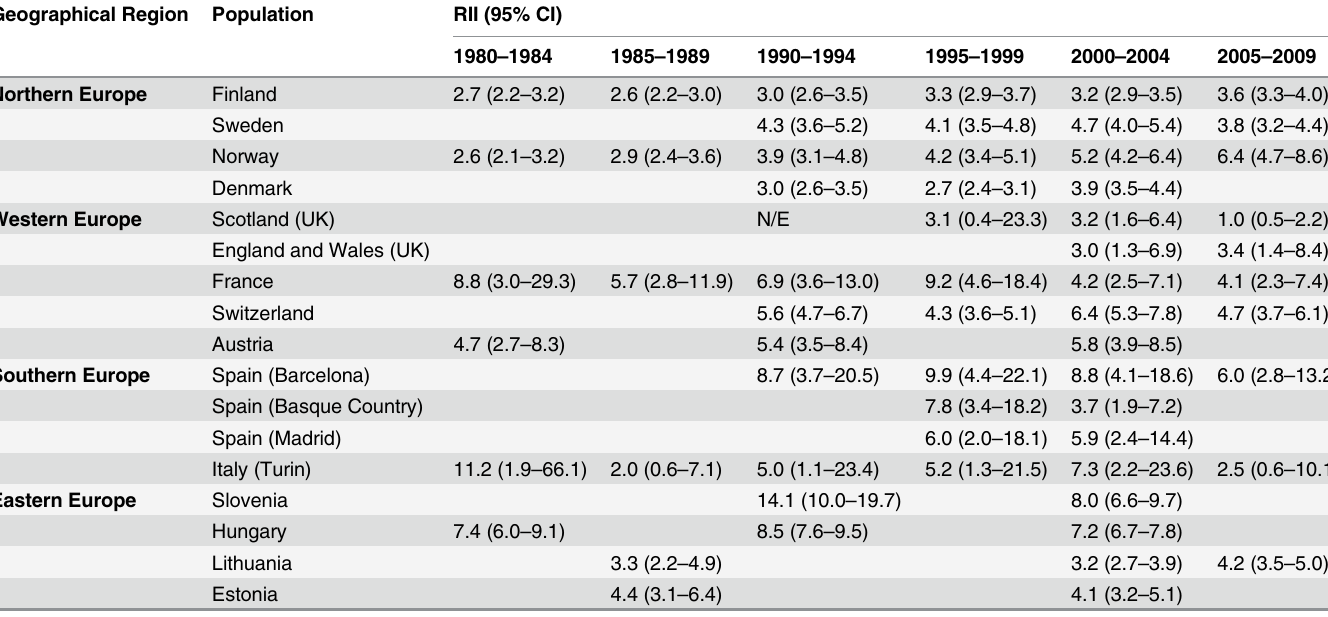
Trend data for England and Wales are available only for the 2000s, because only two levels of education were available for the 1980s and 1990s. Trend data for Belgium, Czech Republic, and Poland are not available because data on alcoholic liver cirrhosis were missing in earlier periods. In Lithuania and Estonia, only mortality due to alcoholic liver cirrhosis and alcohol poisoning were included in this trend table, because comparable data on other alcohol- related causes were not available for earlier time periods. N/E, not